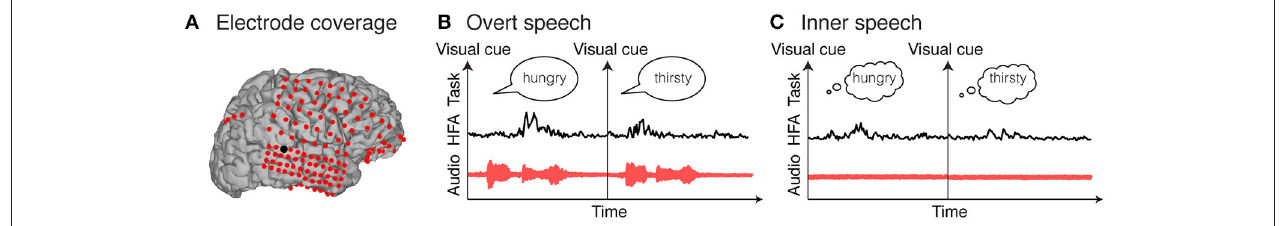
FIGURE 1 | Electrocorticographic recordings. Example of electrocorticographic grid locations overlaid on cortical surface reconstructions of a subject’s MRI scan (A) . Examples of single trial high frequency activity (HFA) for an electrode highlighted in black in (A) . Single trials represent examples of overt speech word repetition (B) and inner speech word repetition (C)